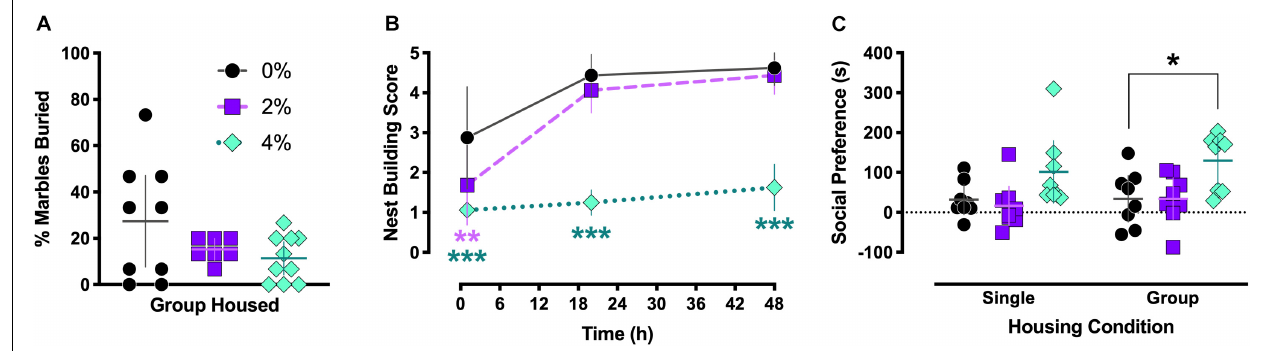
FIGURE 3 | Marble burying, nest building, and social behaviors. Group housed Experiment 2 mice exhibited no significant differences in marble burying behavior ( A ). Nest building behavior was scored for singly housed mice in Experiment 1 at 1, 20, and 48 h after introduction of a nestlet ( B ). After 1 h, nest building was significantly impaired in both 2% ( ∗∗ p = 0.0087) and 4% ( ∗∗∗ p < 0.0001) salt-consuming mice. Nest building by mice consuming 4% salt remained inhibited at the 20 ( ∗∗∗ p < 0.0001) and 48 h ( ∗∗∗ p < 0.0001) time points. Preference for voluntary social interaction ( C ) was significantly increased in group housed mice in Experiment 3 ( ∗ p = 0.015), and a non-significant trend for increased social interaction in singly housed Experiment 1 mice was noted ( p = 0.086). For (A,C) , individual data points are shown, with means indicated by horizontal lines, and 95% CI indicated with vertical lines. Means ( N = 8) are indicated with symbols in (B) , and vertical lines indicate 95%